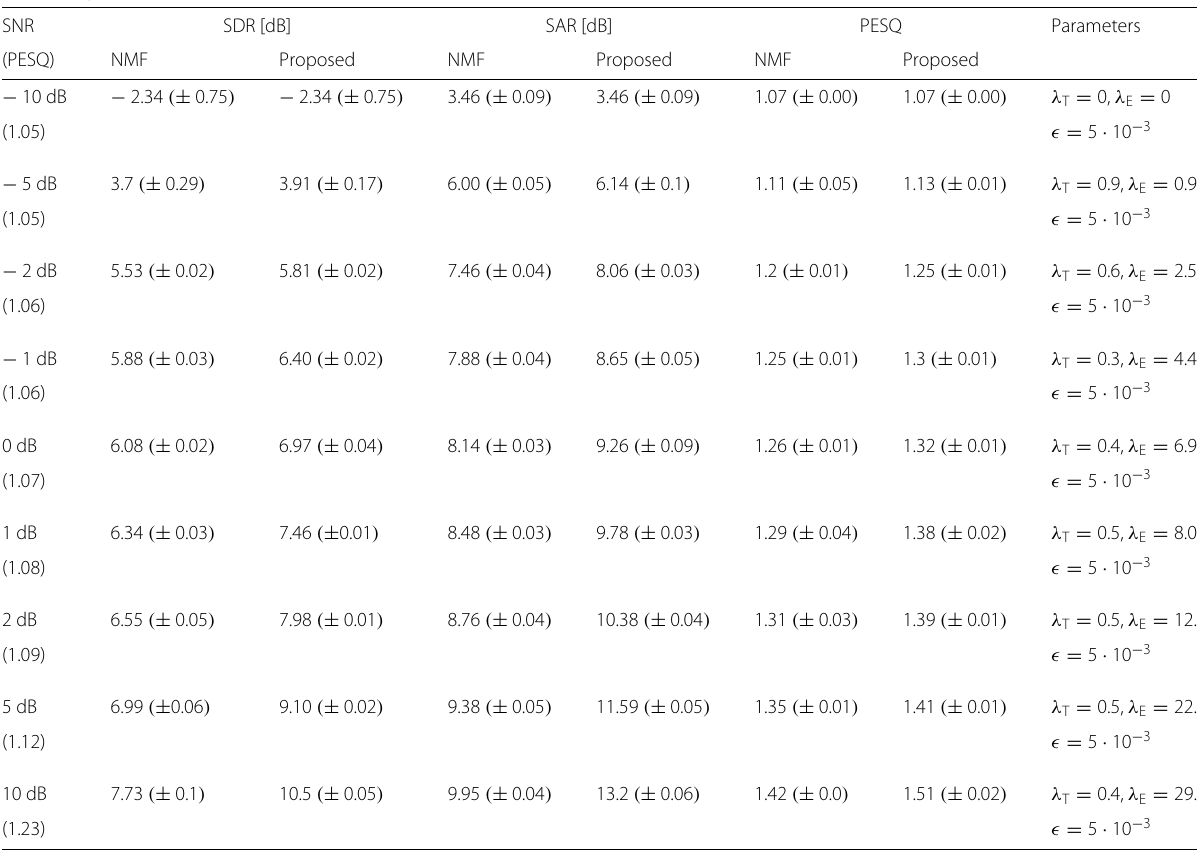
Table 4 Suppression performance achieved by NMF and the proposed method for varying SNRs. For this experiment, ego-noise by movements of Sequence III is used. Parameters used for proposed methods are given in the last rows. For all SNRs, dictionaries of size K = 30, K S = 20 are used